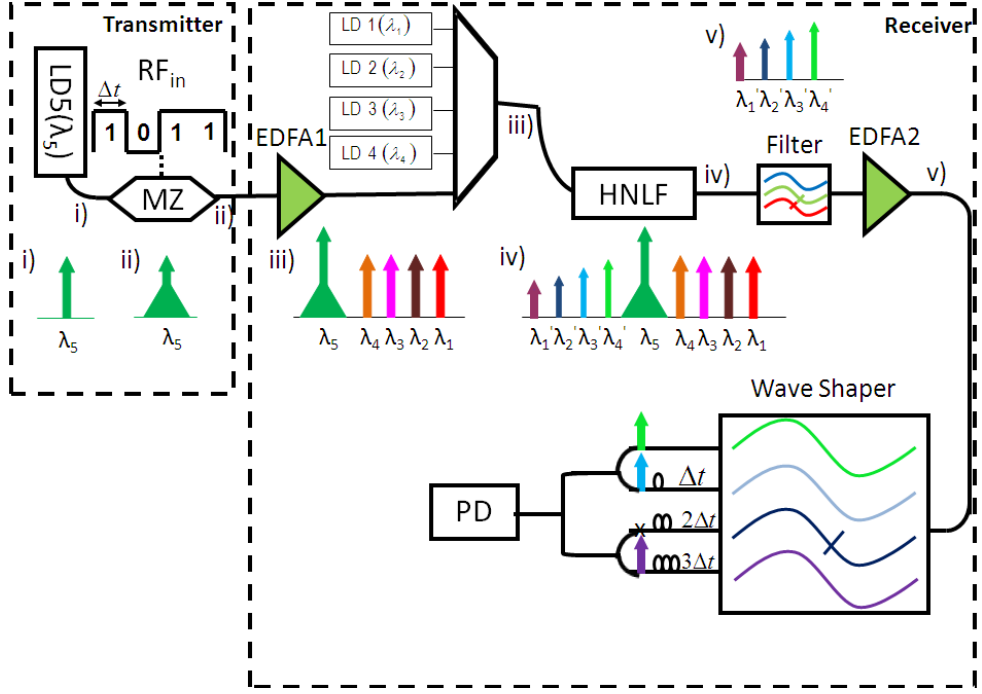
Figure 7. Characterization and experimental